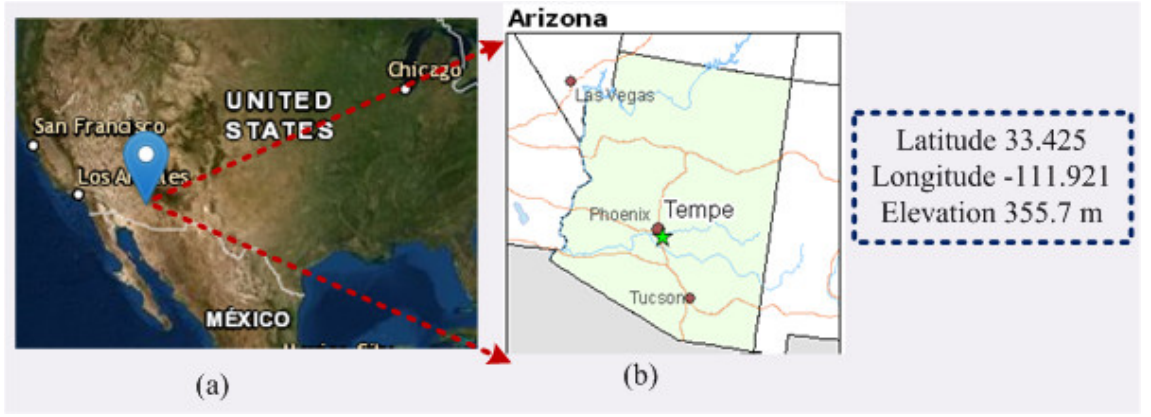
Figure 2. Location of the study area under consideration in this manuscript. ( a ) zoom-out view; ( b ) zoom-in view. Source: Internet.